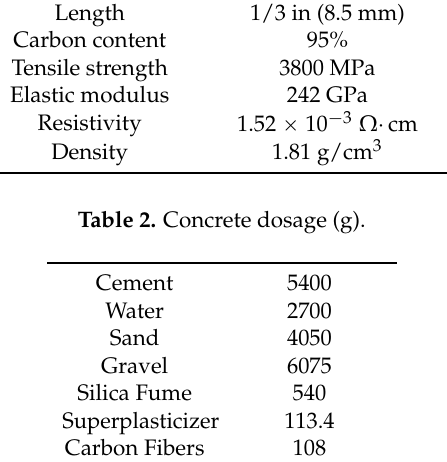
Table 2. Concrete dosage (g).